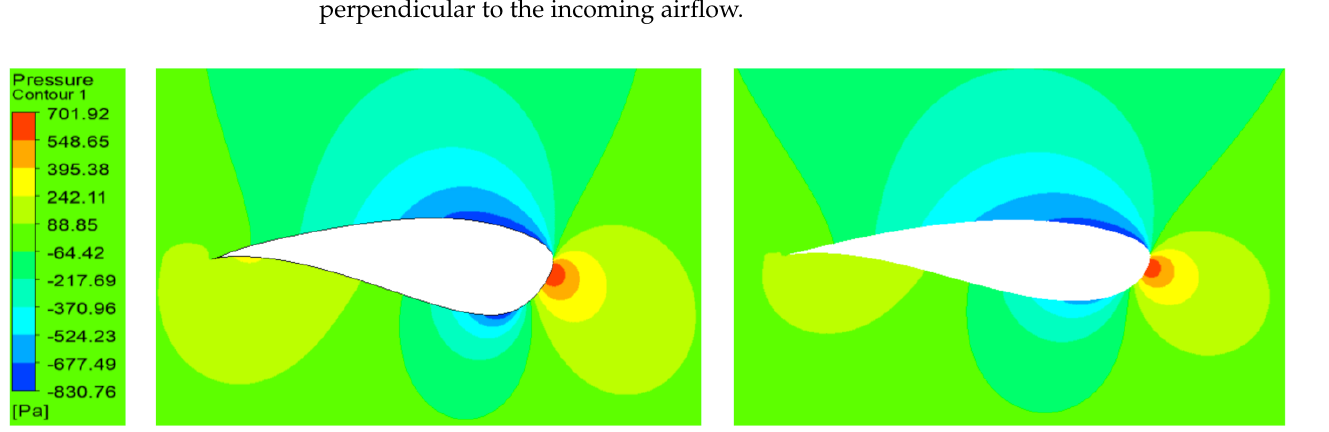
Figure 14. Pressure contour for the original ( left ) and the optimized airfoil ( right ) (NREL